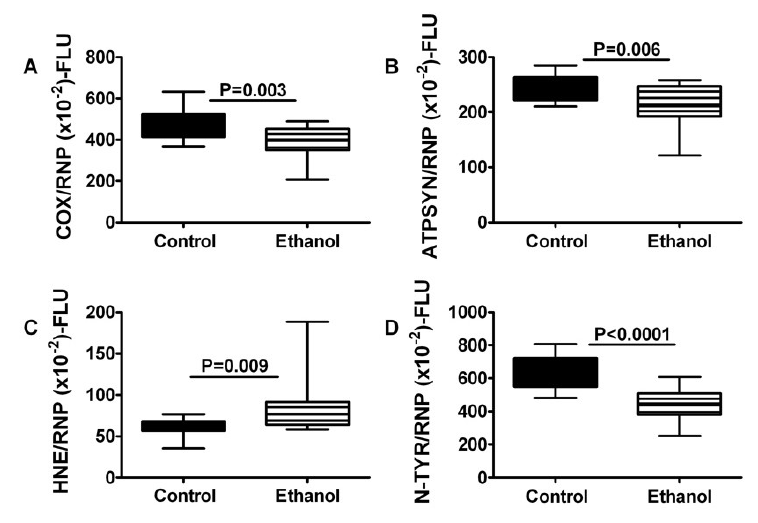
Figure 5. Chronic ethanol feeding impairs mitochondrial oxidative phosphorylation and increases oxidative stress in skeletal muscle. Gastrocnemius muscles from control and chronic ethanol fed rats were used to measure immunoreactivity to ( A ) Complex IV, cytochrome c oxidase (COX); ( B ) ATP synthase (ATPSYN); ( C ) 4-hydroxy-2-nonenal (HNE); and ( D ) 3-nitrotyrosine (NTyR) with a direct binding duplex ELISA in which large ribonuclear protein (RPLPO) expression was used to normalize results. Inter-group comparisons were made with Student t